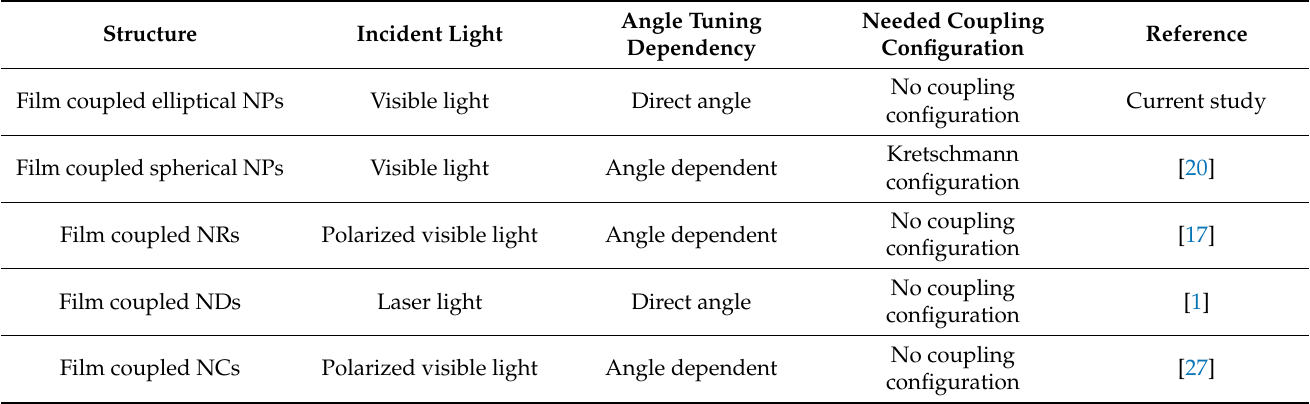
Table 1. Comparison of the present structure with the other related works in terms of needed LSPR induction